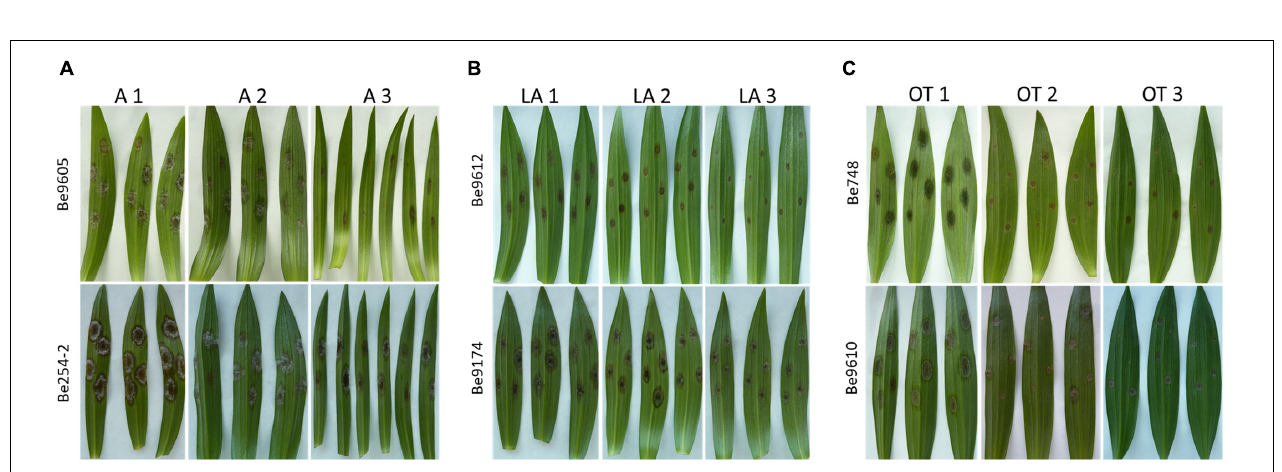
FIGURE 3 | Necrotic lesions at 4 dpi on leaves of three different lily genotypes belonging to the hybrid group Asiatic inoculated with Be9605 and Be254-2 (A) , hybrid group LA inoculated with Be9612 and Be9174 (B), and hybrid group OT inoculated with Be748 and Be9610 (C) .